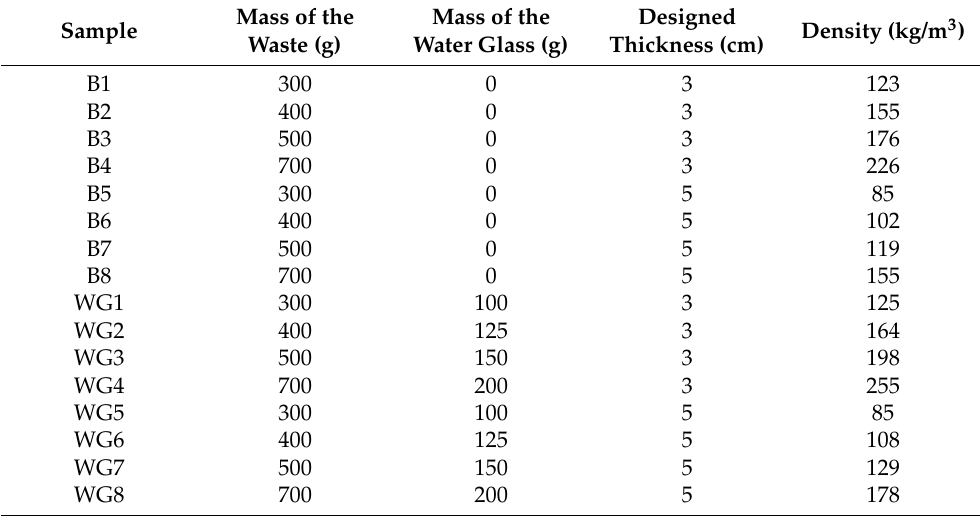
Table 1. Composition, thickness and final density of the produced thermal insulation slab samples.